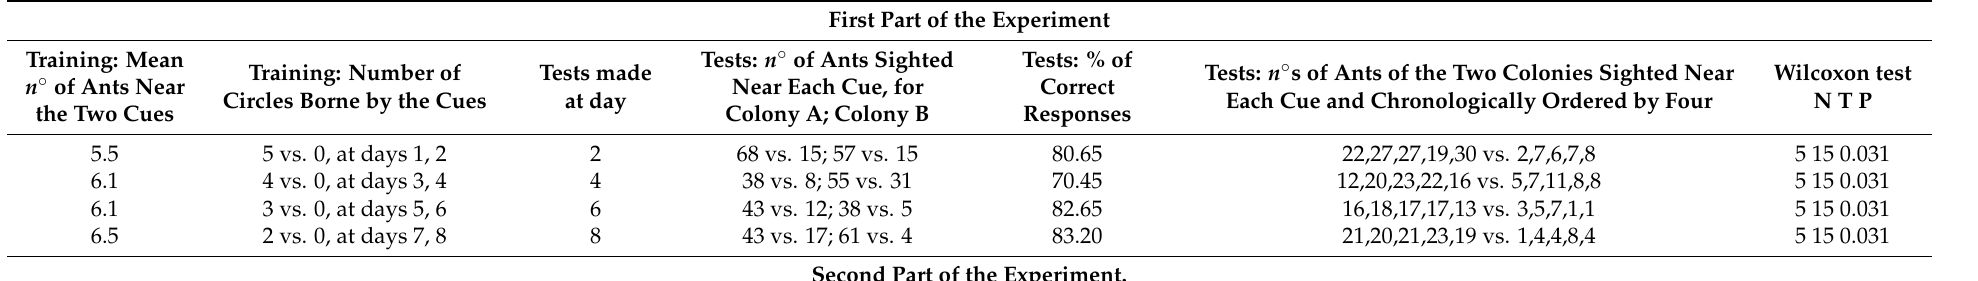
Table 2. Results of experiments made for examining if ants could anticipate the following number in a decreasing sequence of numbers. First Part of the